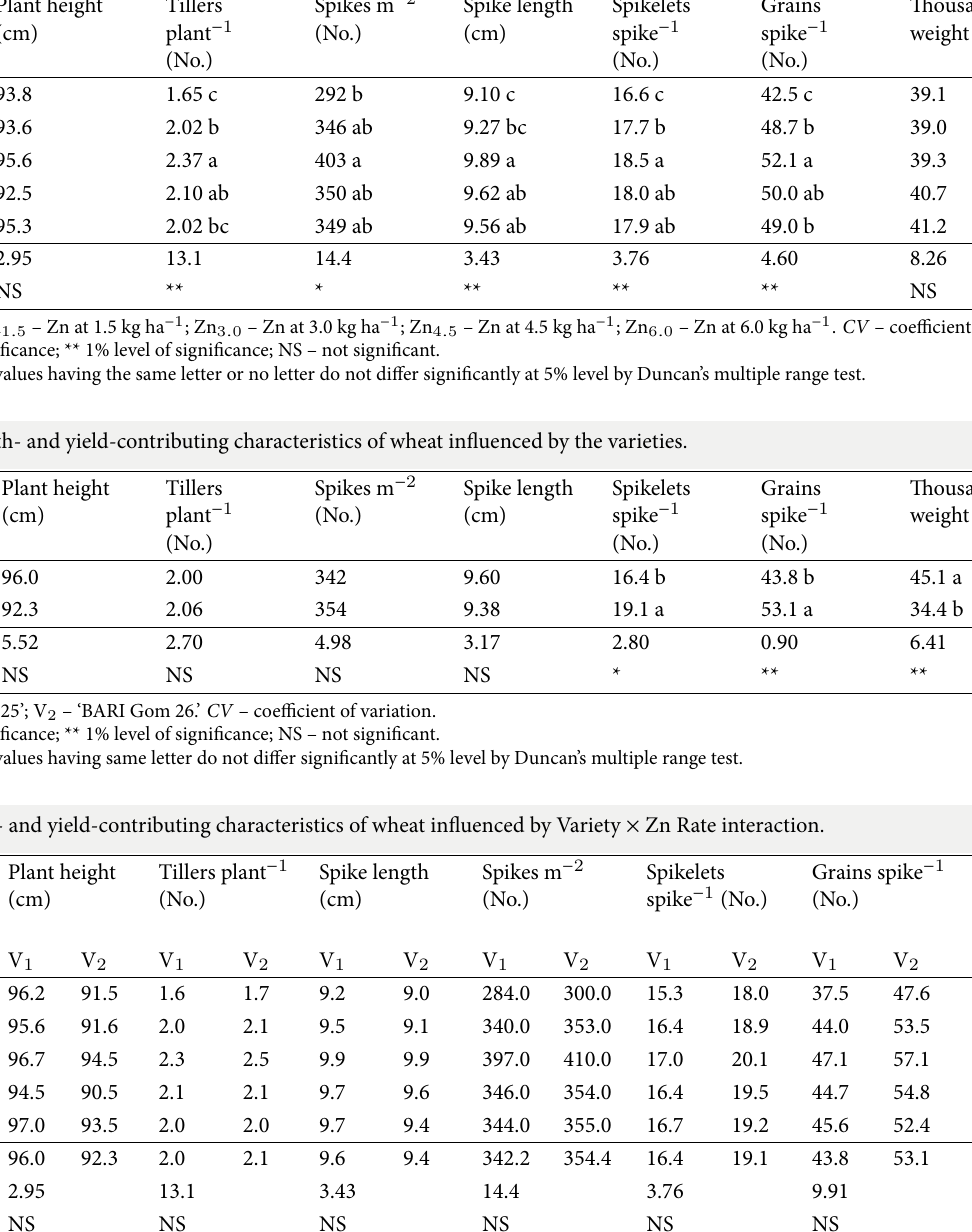
Table 1 Growth- and yield-contributing characteristics of wheat influenced by Zn rates. Levels of Plant height Zn